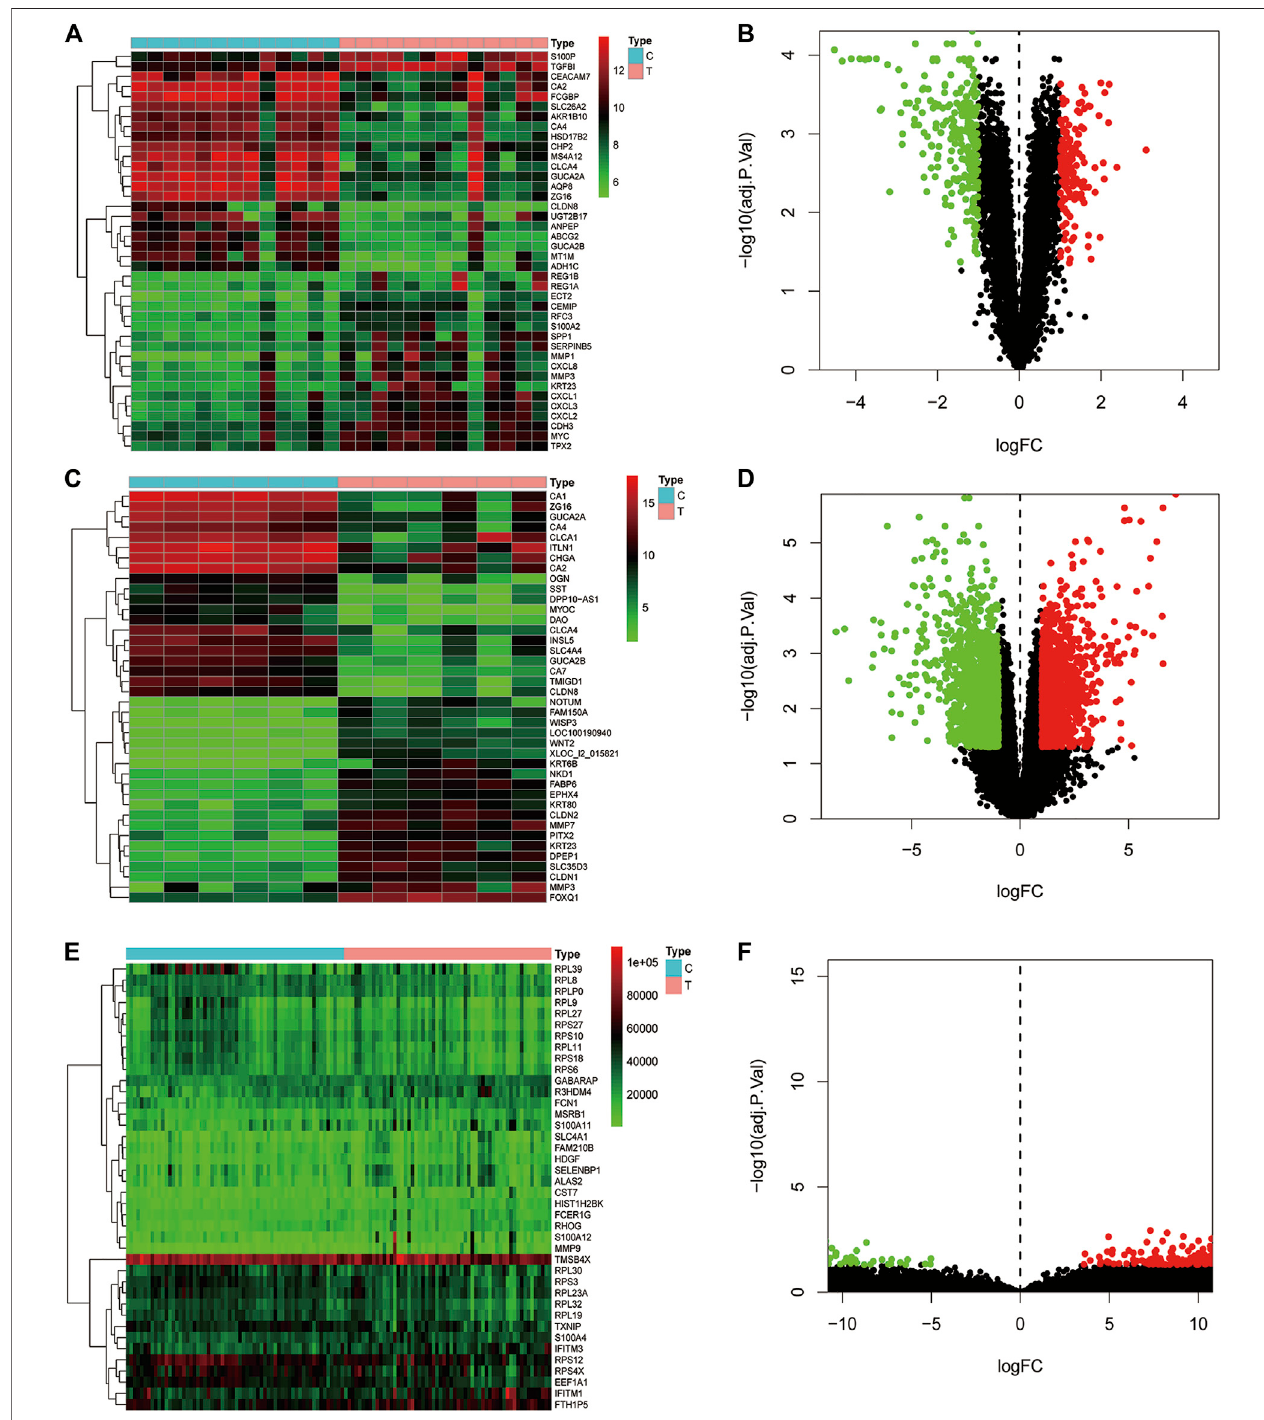
FIGURE 2 | Analysis of differential gene expression in three datasets associated with colorectal cancer and normal tissue (GSE164191, GSE110225, and GSE156355)inGEOdatabase.Atotalof6,649,406,2954differentiallyexpressedgeneswerescreenedfromnormaltissuesandcolorectalcancertissues,respectively. Heat maps and scatter maps were drawn according to different expression levels of differentially expressed genes, and some differentially expressed genes were selected for display. In the fi gure, red represents high expression, and green represents low expression. (A , B) Heat map and scatter map of differential genes in GSE164191 dataset. (C , D) Heat map and scatter diagram of differential genes in GSE110225 dataset. (E , F) Heat map and scatter diagram of differential genes in GSE156355 dataset.